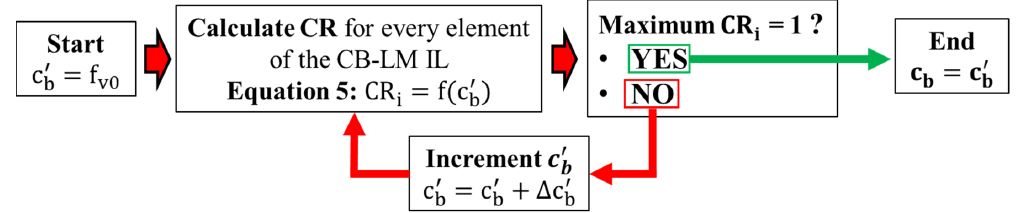
Figure 8. Iterative process to estimate bond cohesion.